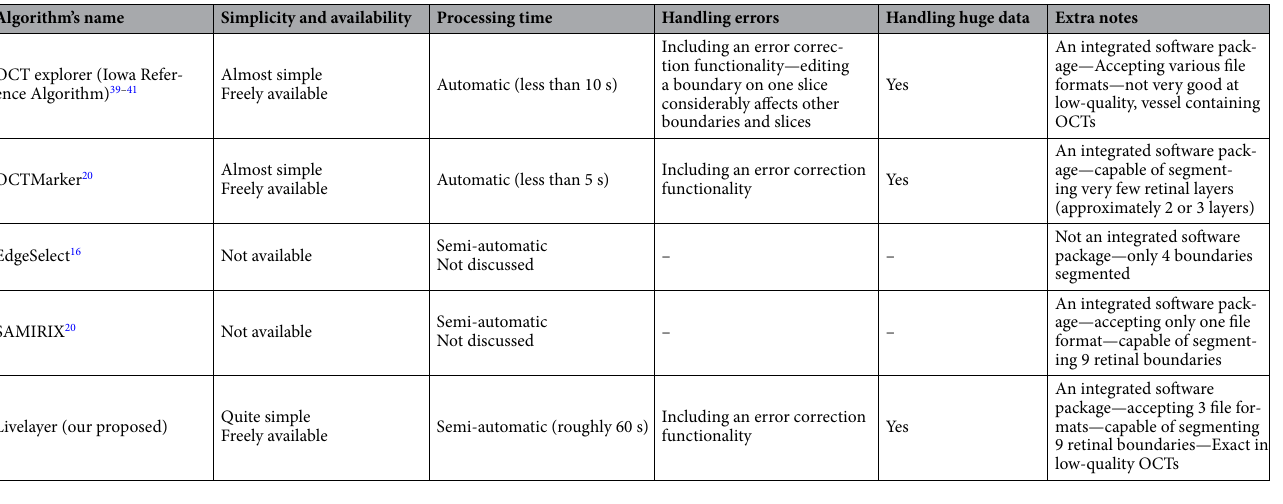
Table 5. A comparison between previously suggested segmentation algorithms and the Livelayer